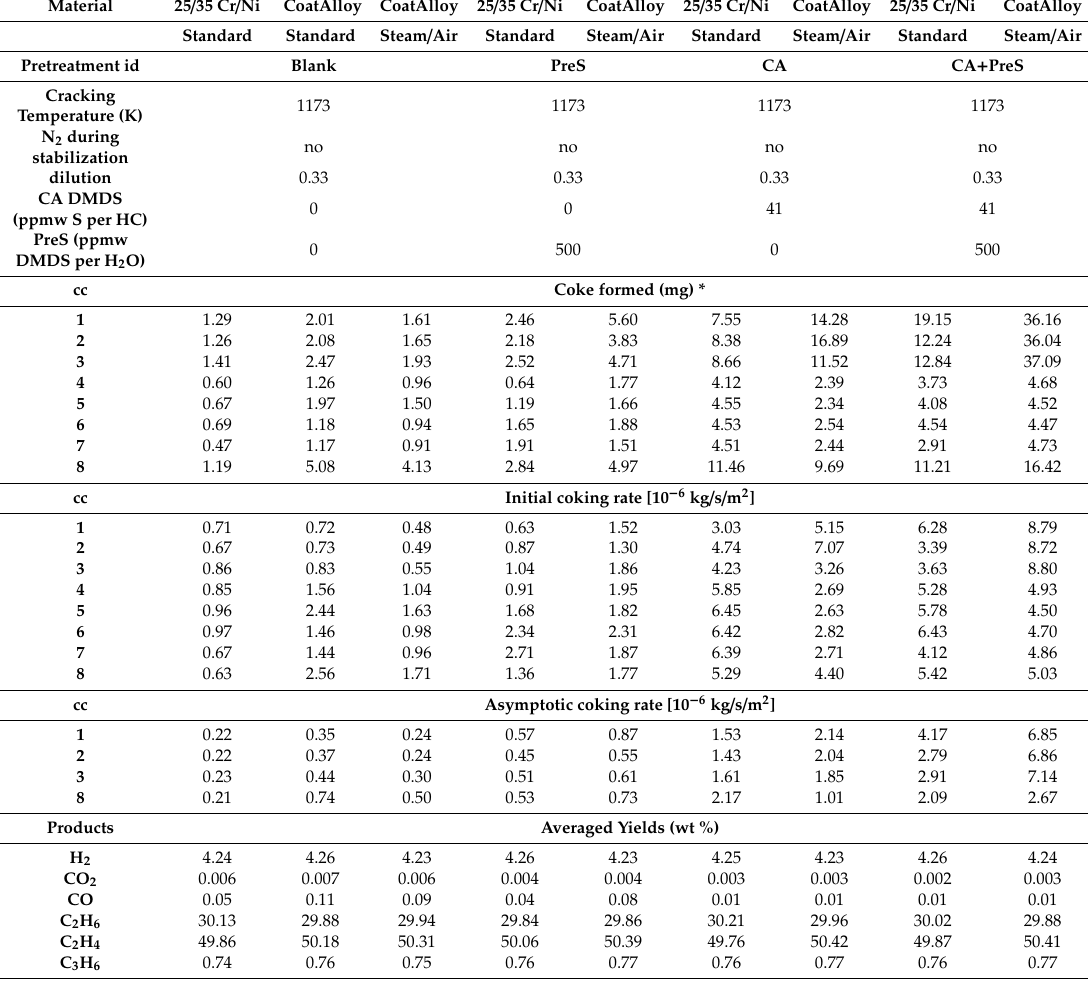
Table 4. Summary of the coking experiments and main